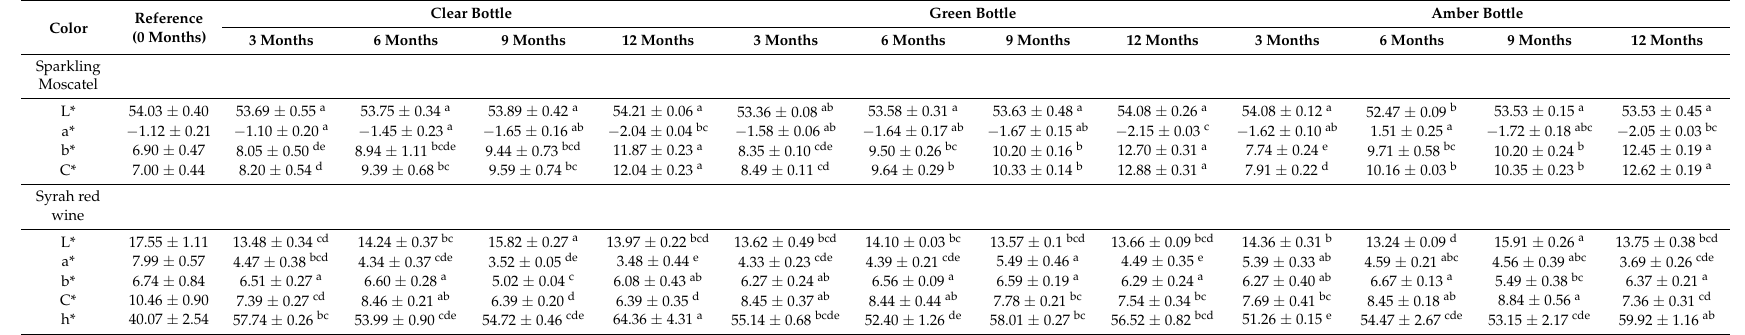
Averages followed by the same letters on a line do not differ between themselves according to the Tukey test ( p <